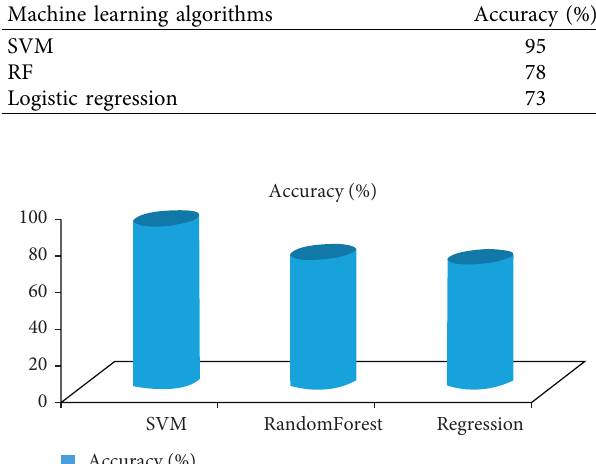
Figure 2: Accuracy of classifiers.